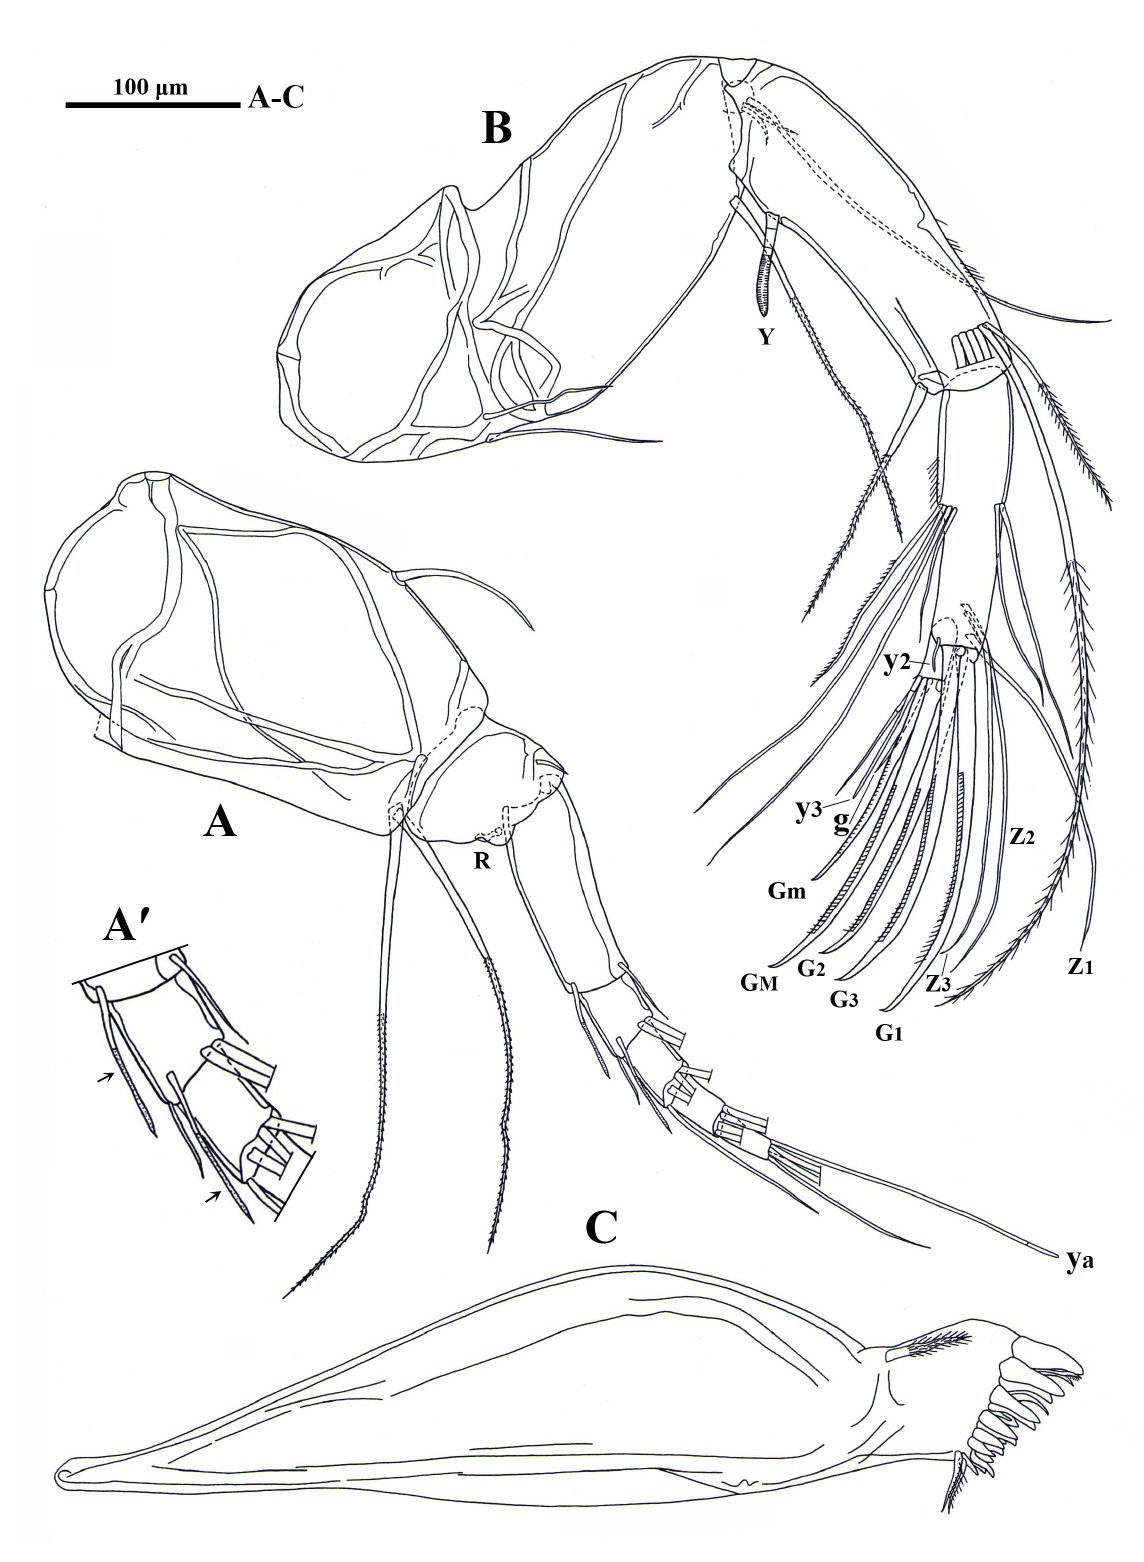
Fig. 8. Strandesia prachuapensis sp. nov. Holotype, ♀ (MSU-ZOC.303). A . A1. Aʹ . Aesthetasc-like setae on third and fourth segments of A1. B . A2. C . Md-coxa. R–Rome